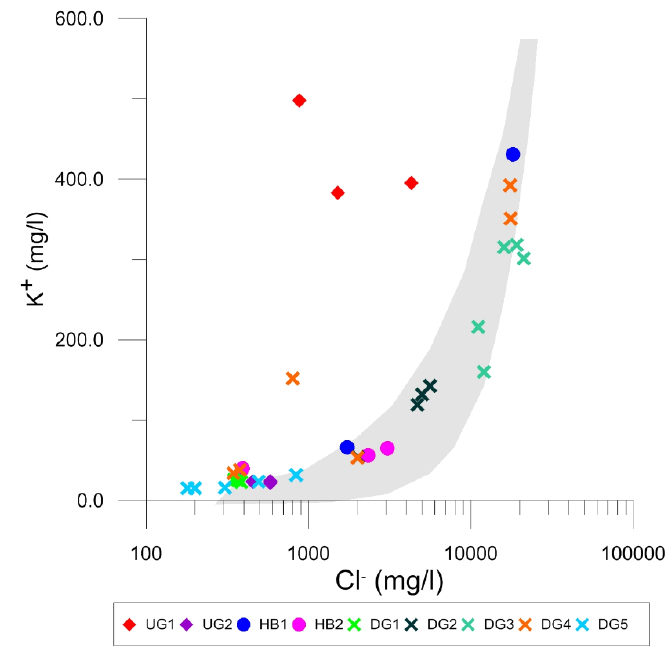
Figure 2. Plot of Cl − versus K + for MLS located upgradient (UG1, UG2), near (HB1, HB2) and downgradient (DG1 ÷ DG5) with respect to the hydraulic barrier (see Figure 1 for sampling site location). The grey shaded area shows the mixing between the background groundwater concentration and seawater.